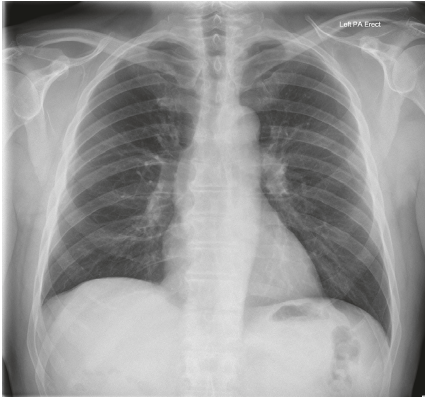
Figure 5: Chest radiograph three months postoperatively showing resolution of right hemidiaphragm paralysis.